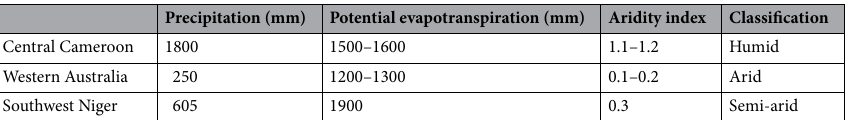
Table 1. Mean annual precipitation, potential evapotranspiration, and aridity index of the regions where localised labyrinthine patterns are observed. For more details on the meteorological data see the references given in the